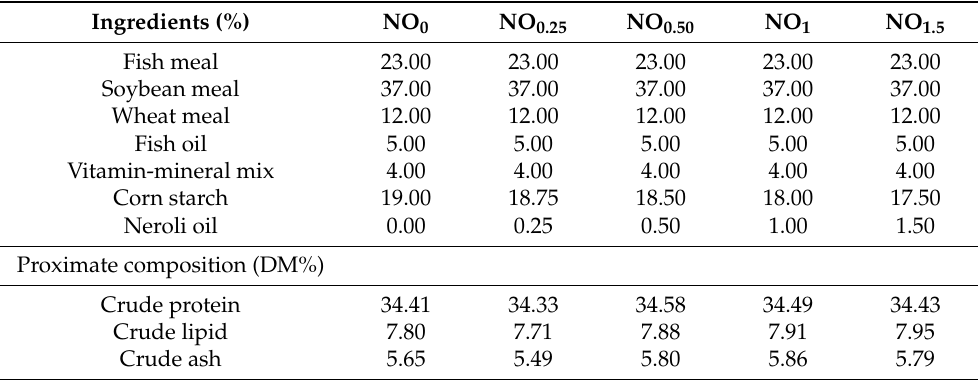
Table 1. Percentage and proximate composition of the experimental diets supplemented with different percentages of neroli oli (NO).